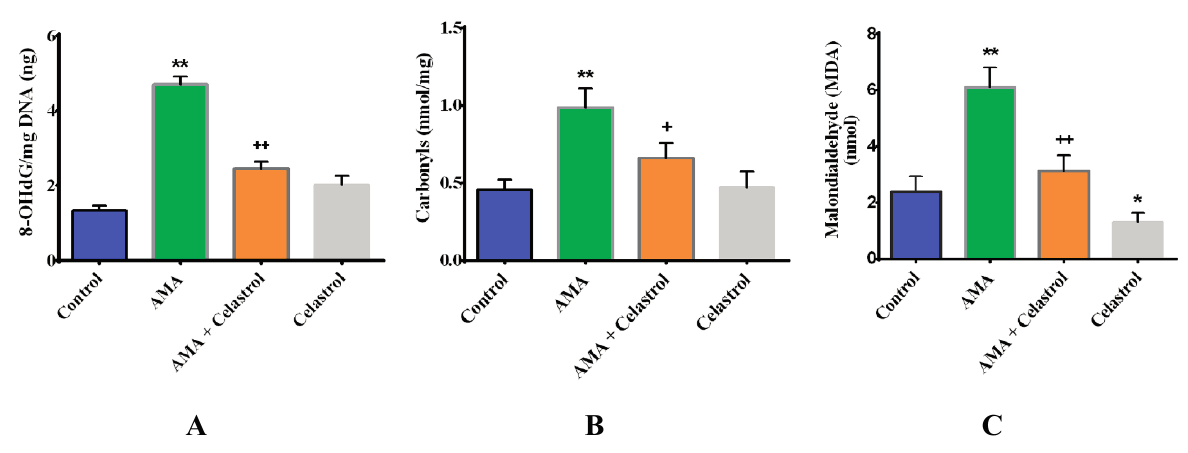
Figure 4. Effects of AMA and celastrol on the oxidative properties of human skeletal muscle. The quantification of 8-OHdG DNA ( A ), protein carbonyls ( B ) and